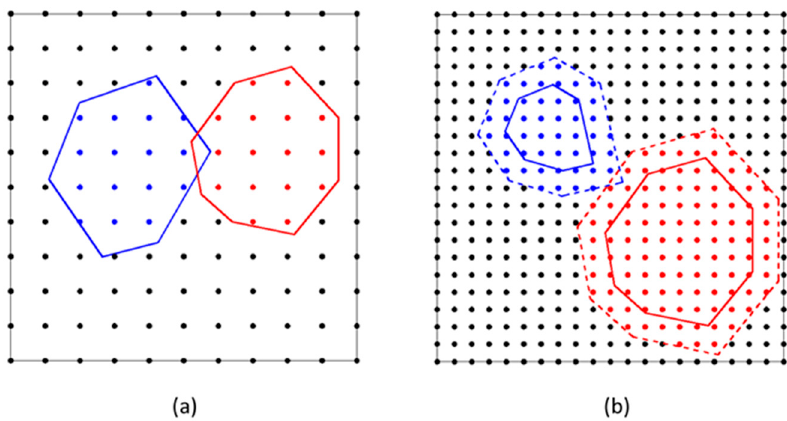
Figure 11. ( a ) In the procedure of placement aggregates, the geometrical overlap between placed aggregate (the red zone) and trial placement one (the blue zone) may occur potentially within the one unit of dot matrix, even though any intersection set between their point sets does not exist at all. ( b ) After detecting the status of intersection set between the points (the blue zone) surrounded by the virtual boundary of a trial placement and the points by the placed one (the red zone), the determination of the locations and vertexes in the trial placement aggregate is stored or not.